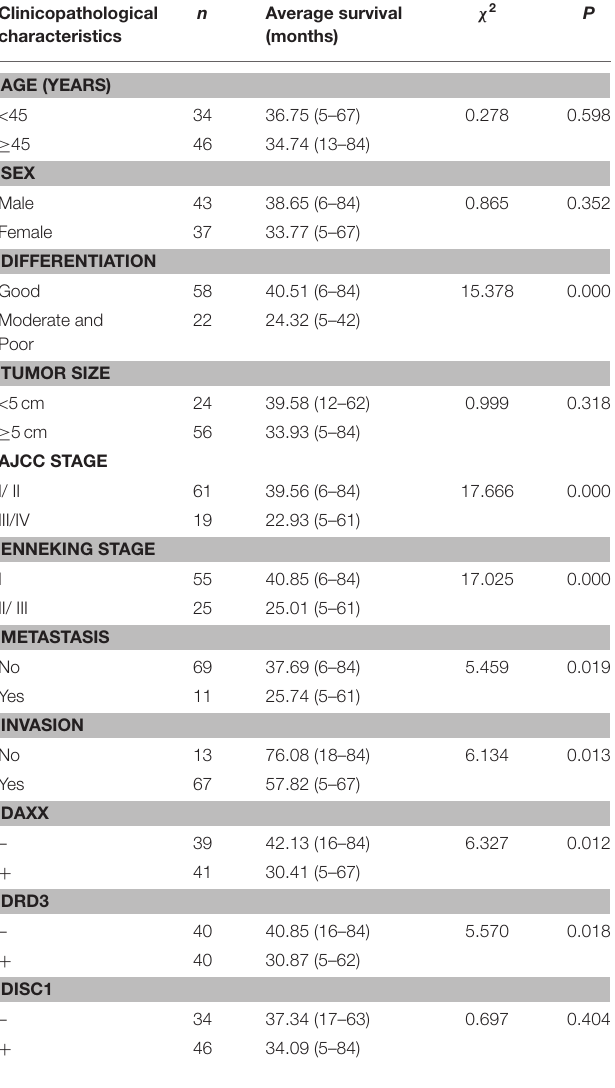
TABLE 3 | Relationships of DAXX, DRD3, and DISC1 expression and clinicopathological characteristics to average survival in patients with chondrosarcoma.